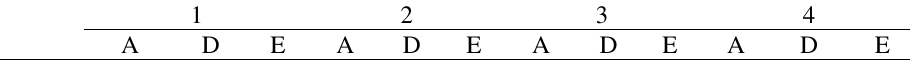
Table 2 . Optimized geometrical parameter (bond lengths in Å), the values between brackets is for hydantoin adapted from